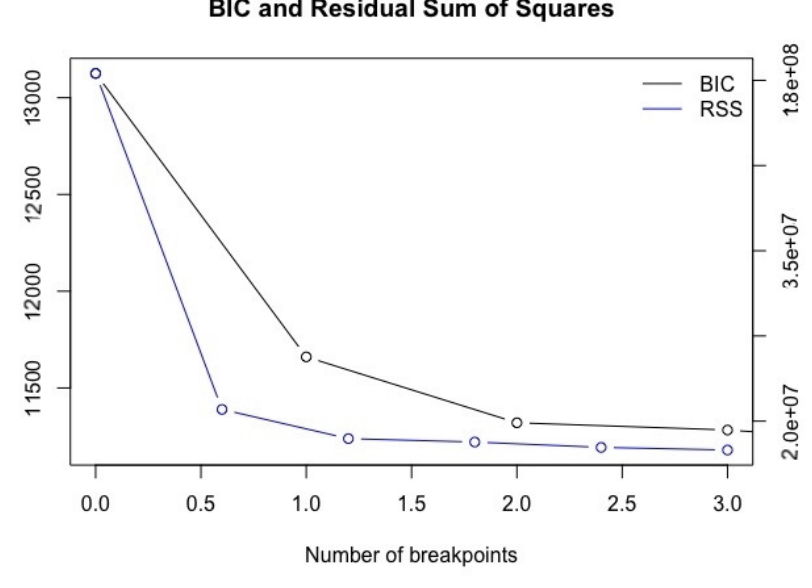
Figure 1. Behavior of the RSS and BIC varying the number of breakpoints from 0 to